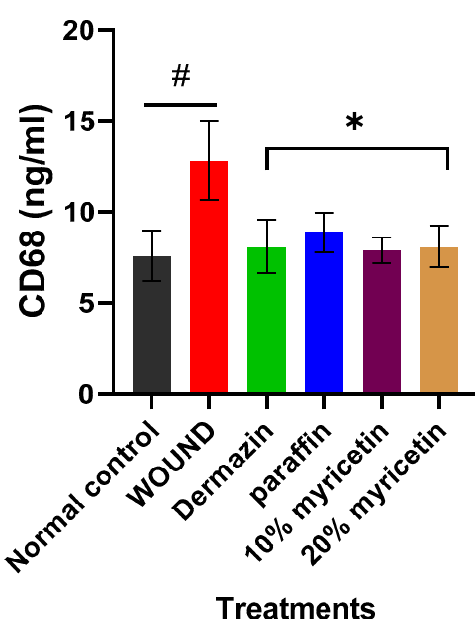
Figure 2. E ff ect of myricetin treatment on serum levels of CD68 in rats. * p < 0.05 versus wounded rats, # p < 0.05 versus normal control.